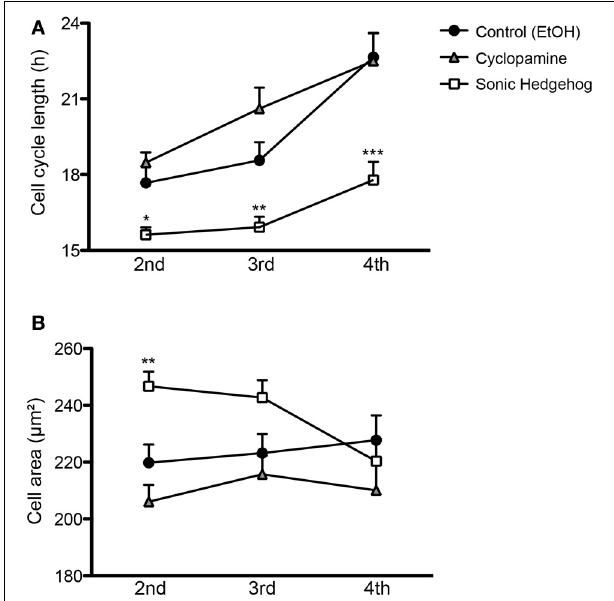
FIGURE 5 | SHH signaling influences cell cycle length and cell size of cortical progenitors. (A,B) Quantification of cell cycle length (A) and cell area prior to division (B) of cortical progenitors in the second, third and fourth generations. ∗ p < 0 . 05, ∗∗ p < 0 . 01, ∗∗∗ p < 0 . 001, One-Way ANOVA followed by Dunnet post-hoc test (Number of cells analyzed, second generation—Control: 55, Cyc: 51, SHH: 75; third generation—Control: 60, Cyc: 27, SHH: 59; fourth generation—Control: 40, Cyc: 19, SHH: